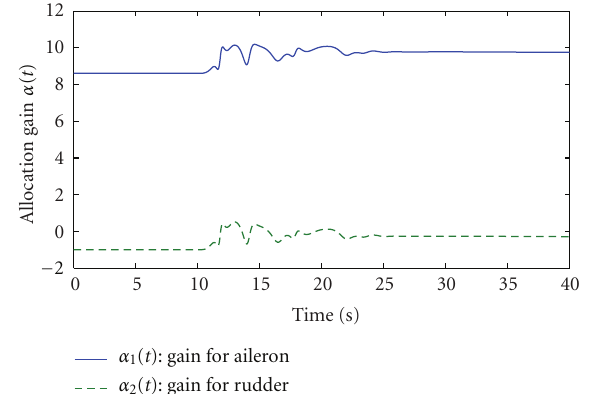
Figure 5: Time history of allocation gains (Case 1).